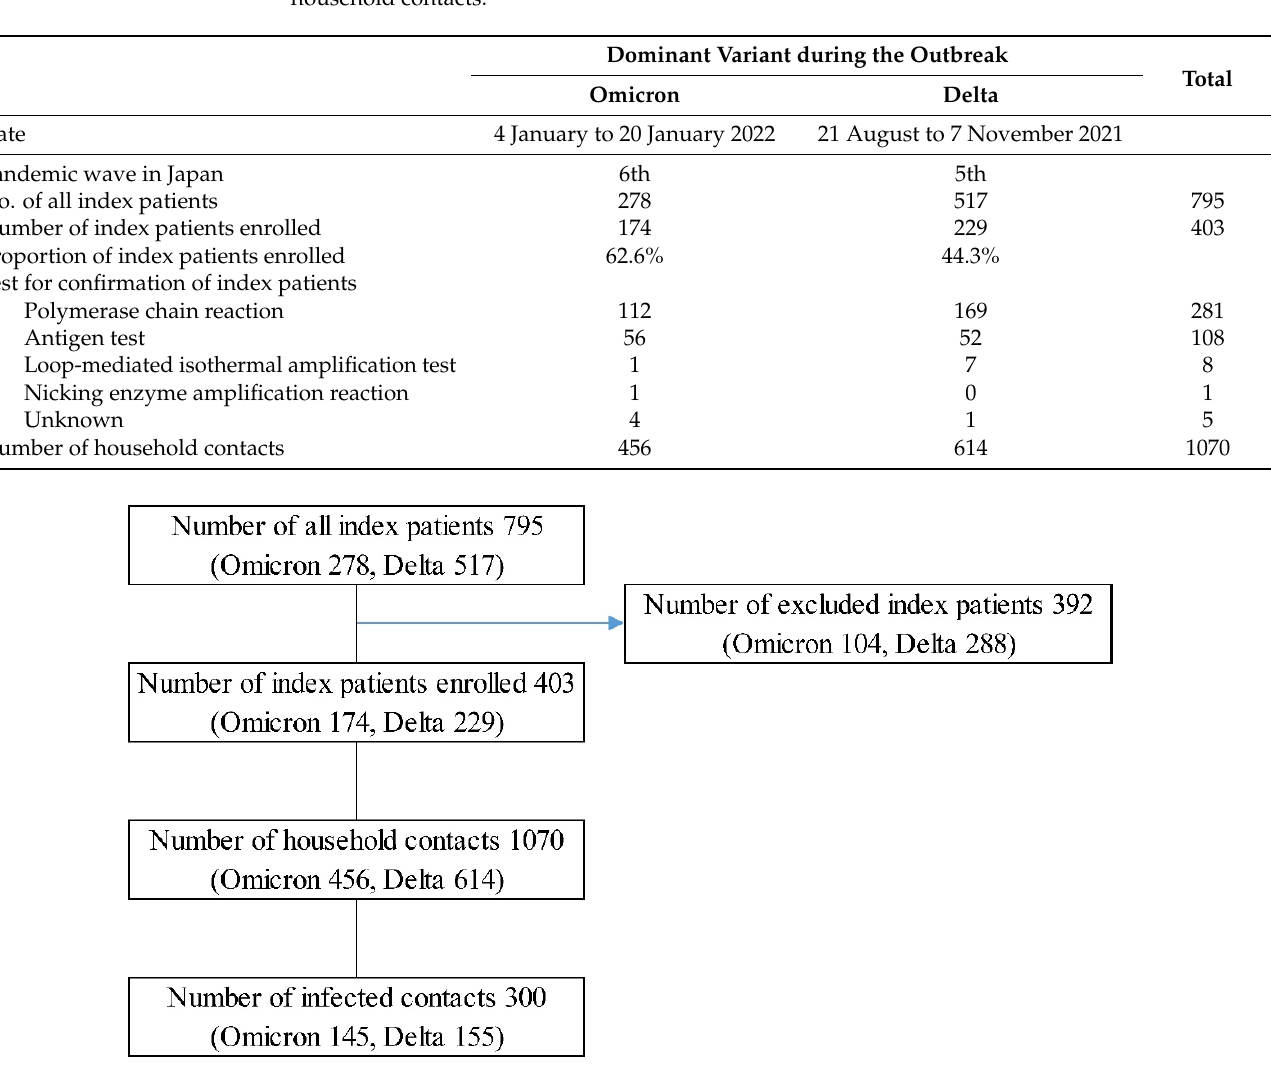
Figure 1. Flow chart of the enrollment of index patients and household contacts. Table 1. Study period, enrollment of index cases, tests for case confirmation, and the number of household contacts.